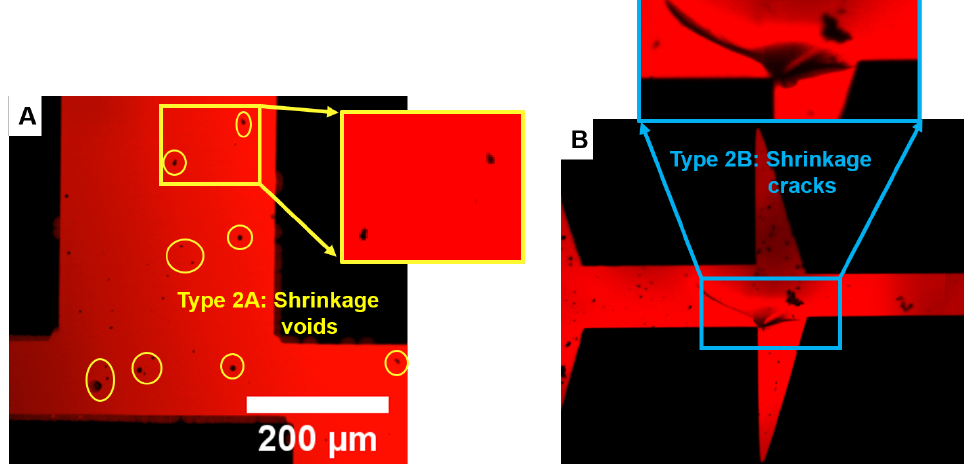
Figure 7. Confocal images of type 2 shrinkage defects: ( A ) The voids in the resin that have 10–40 µ m size. ( B ) The rough shrinkage cracks that develop across the structure indicate high residual shrink- age